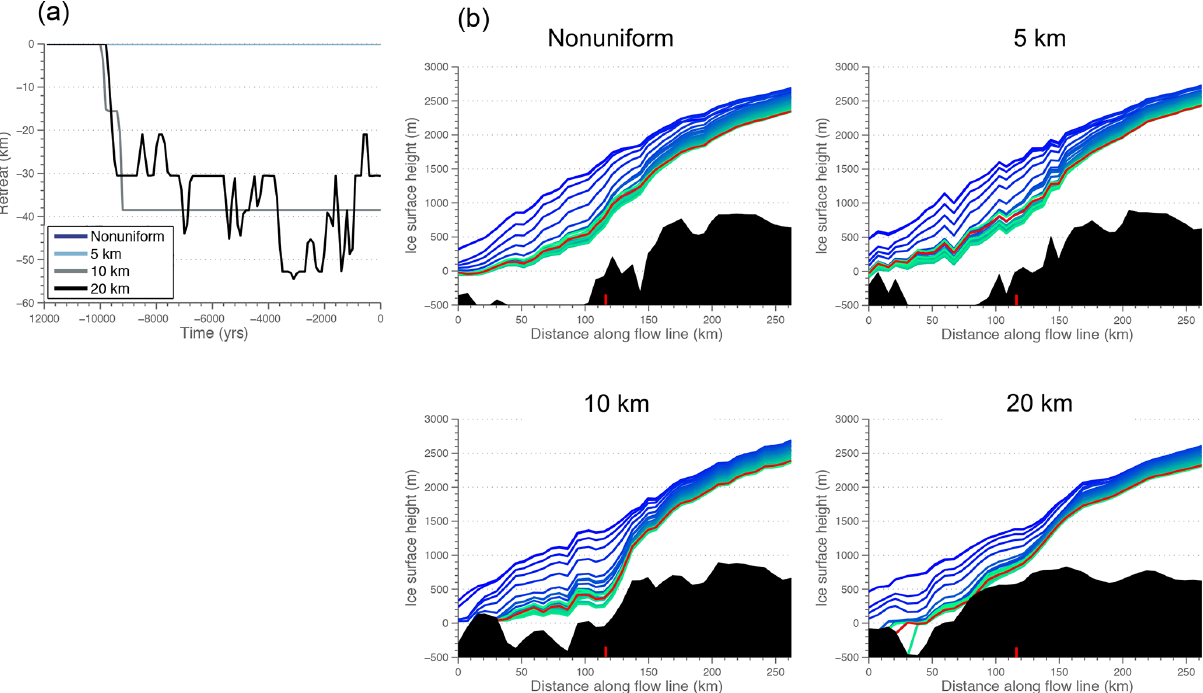
Figure 8. Same as in Fig. 7 but for flow line